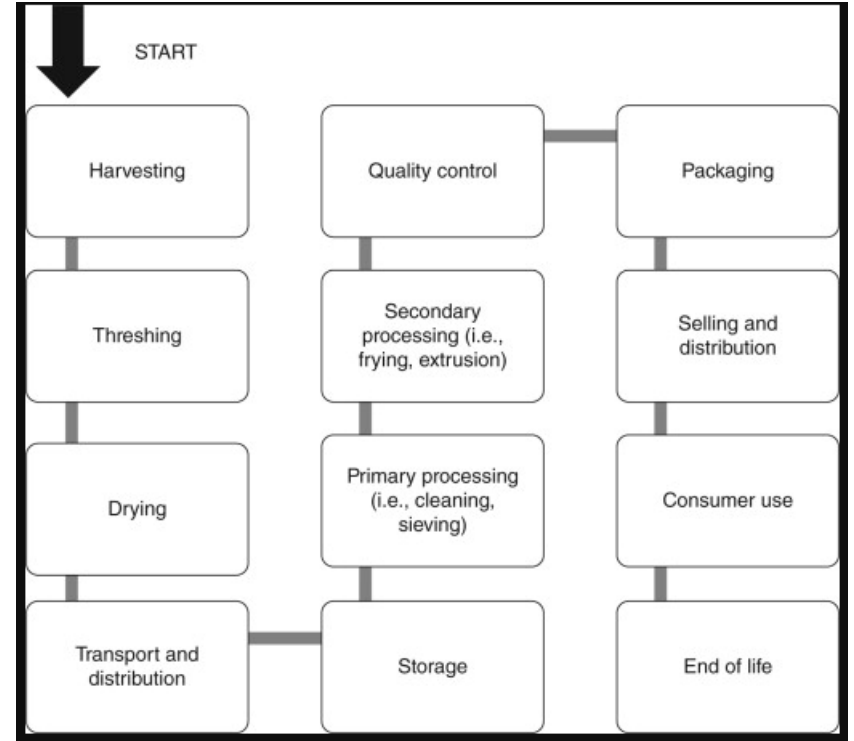
Figure 2. Process diagram for the perishable food supply chain. Adapted from L.A. Pfaltzgraff and J.H. Clark [32].